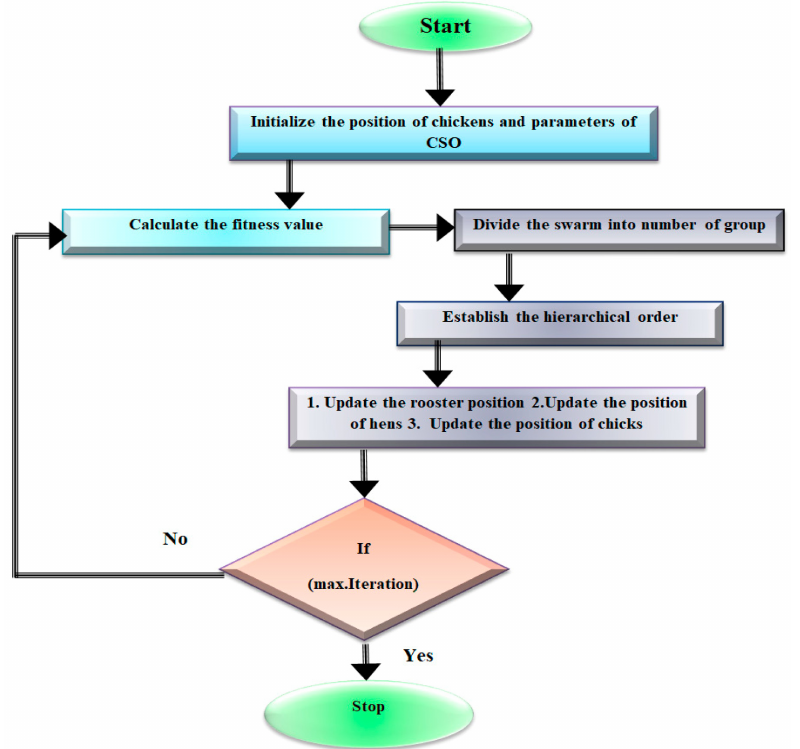
Figure 3. Flowchart for CSO